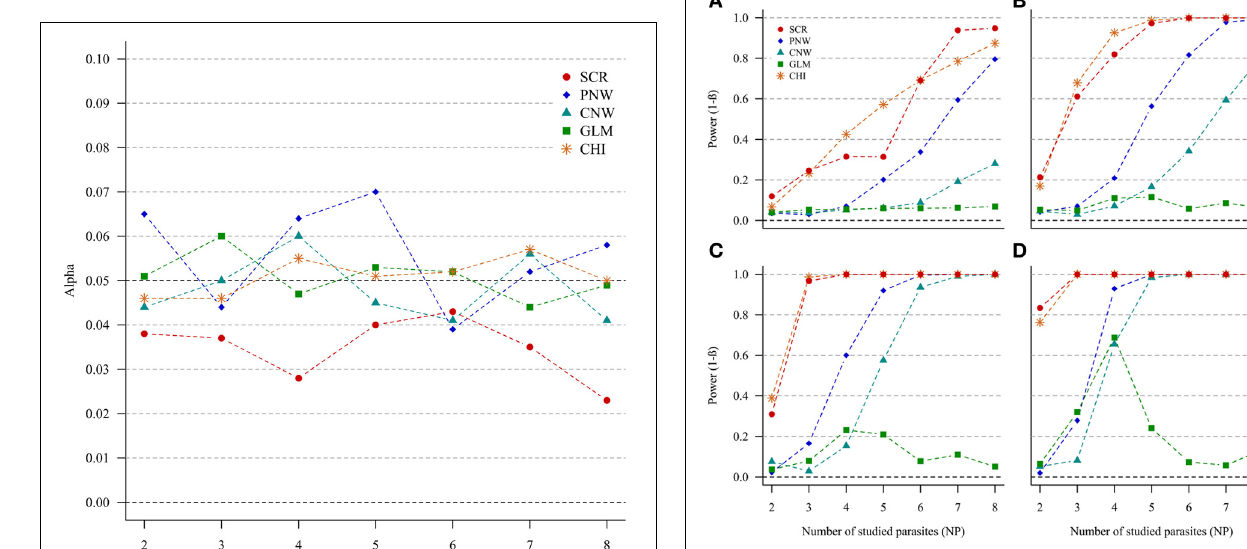
FIGURE 2 | Simulation outputs relative to the test of power (1- β ) for the four approaches used to detect host structuring, with a prevalence ratio equal to 0.5. CHI, generalized chi-square test; PNW, parasite network model; CNW, combination network model; GLM, multinomial GLM model and SCR, the association screening approach. The number of parasites varied from two to eight, the size of the total host population was fixed to 1000 and the ratios of host subpopulation sizes varied (A) 0.2. (B) 0.3. (C) 0.4. (D)